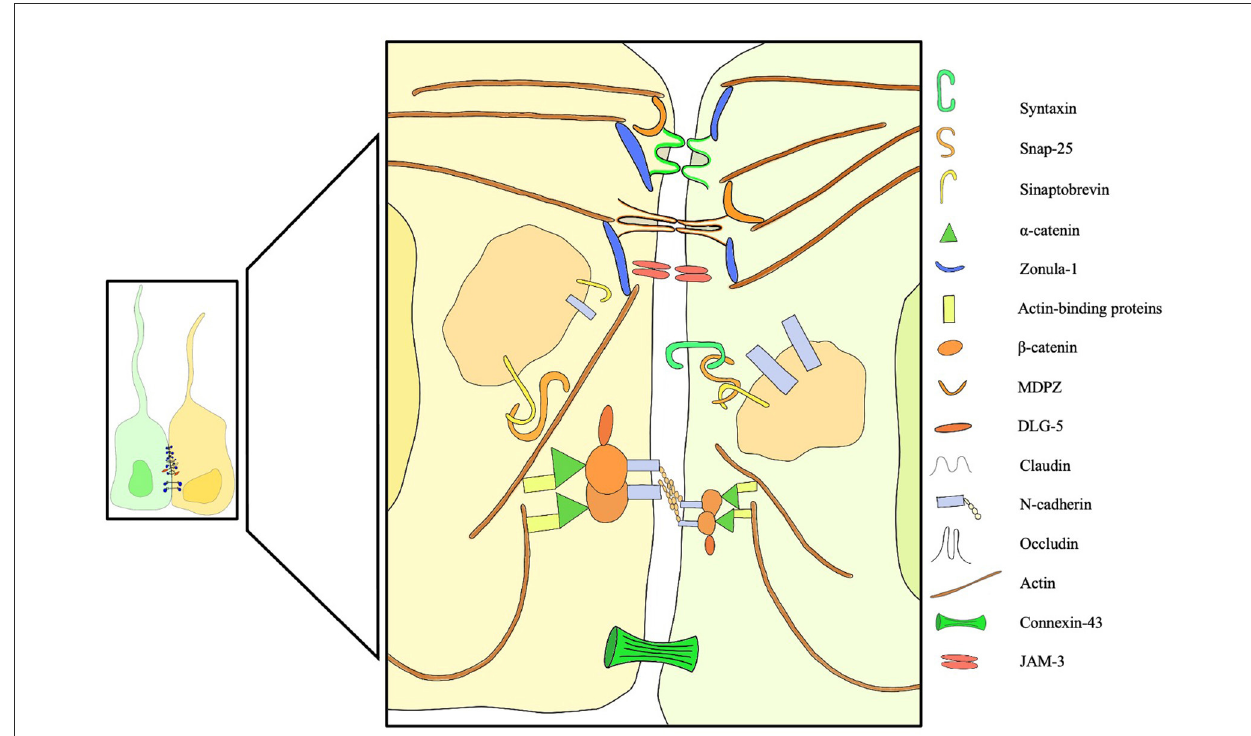
FIGURE2 Overview of membrane, trafficking, junctional, cytoplasmic structural proteins involved in intercellular junctions and pathological processes of the ependyma. Failure of one of these components can induce ependymal denudation and hydrocephalus in murine models. A dedicated legend is provided with the